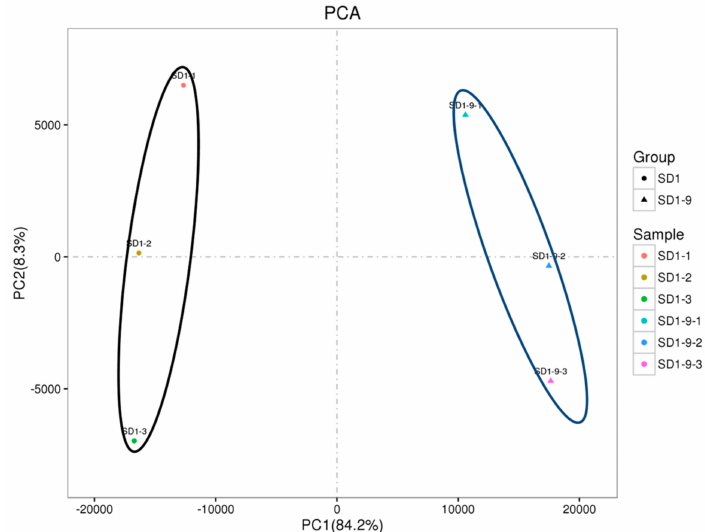
Figure 4. Principal component analysis of the P. capsici samples. The black circle represents the control 1 (SD1-1), control 2 (SD1-2), and control 3 (SD1-3) samples. The blue circle represents P. capsici SD1-9 samples; SD1-9-1, SD1-9-2, and SD1-9-3 are the three biological